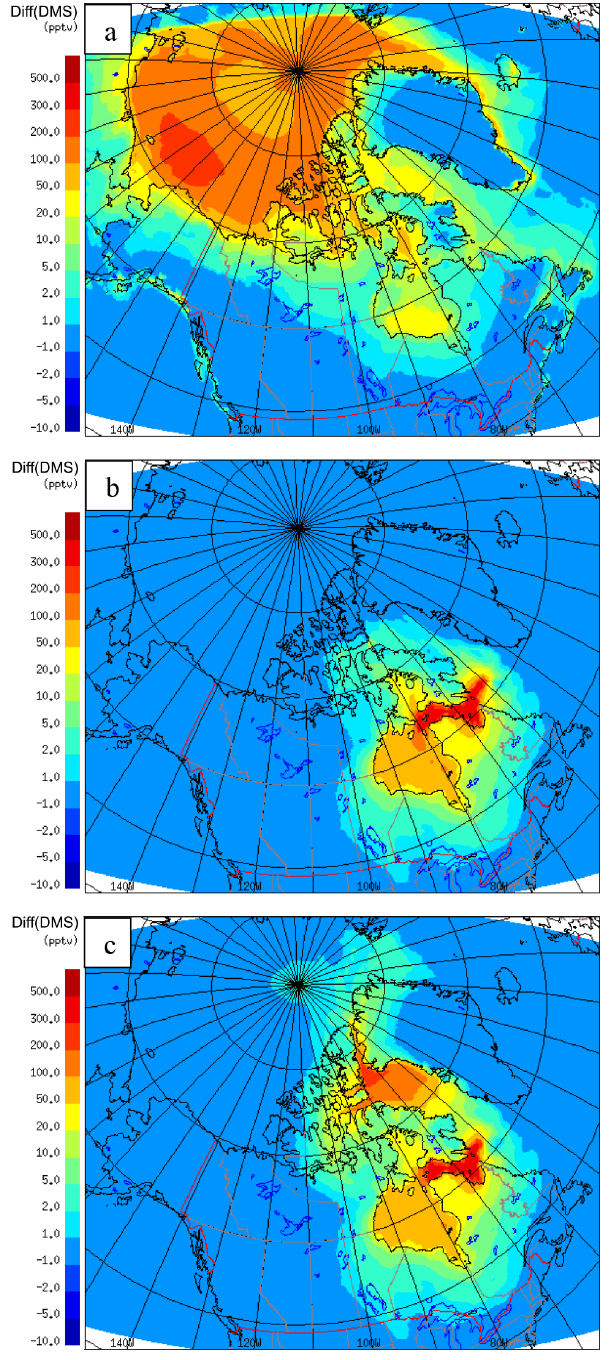
Figure 9. The difference between the DMS(g) July average from CLIM11 for (a) no-Ice, (b) HB + HS and (c) CLIM11 + ave-Obs.